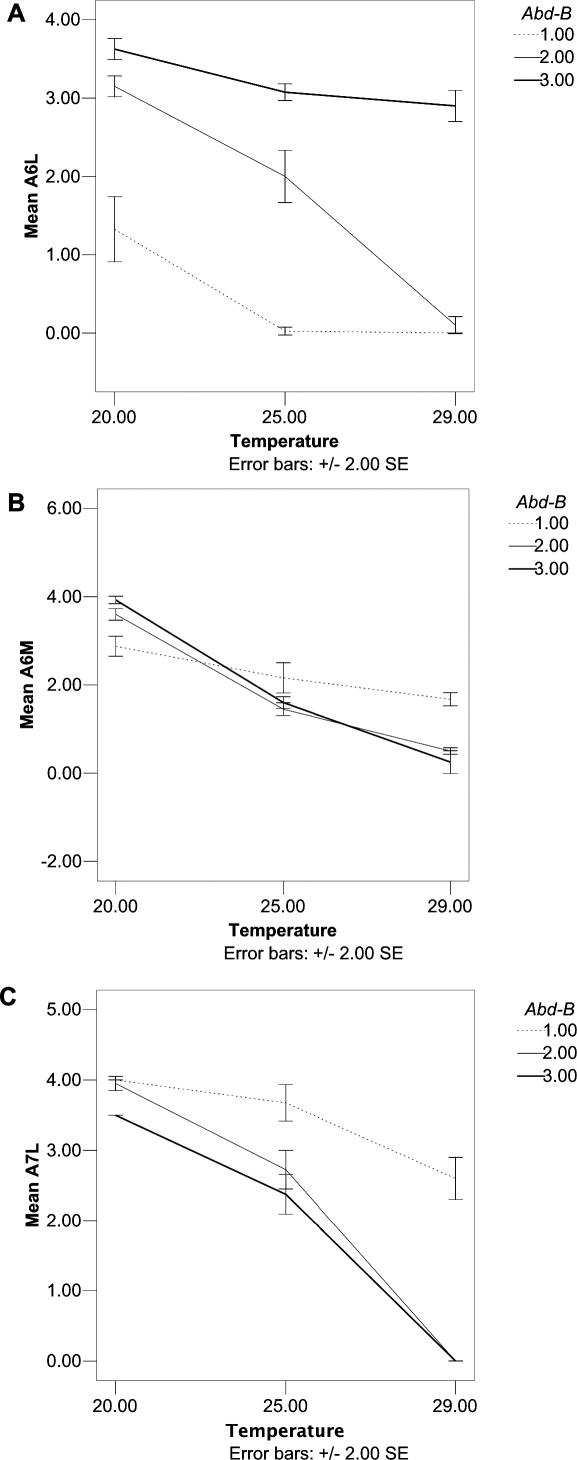

Abd-B Interacts with Temperature in the Regulation of Melanin ProductionShows the effect of variation of Abd-B dosage (1, 2, or 3 copy number) and temperature on melanin production in the lateral region of A6 (A), the median region of A6 (B), and the lateral region of A7 (C).